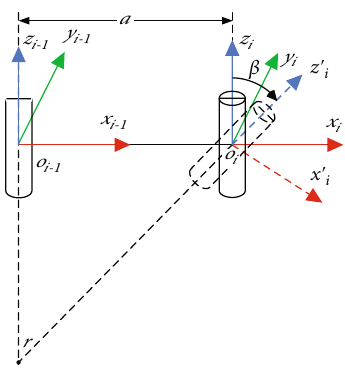
Figure 1: Singularity of the DH